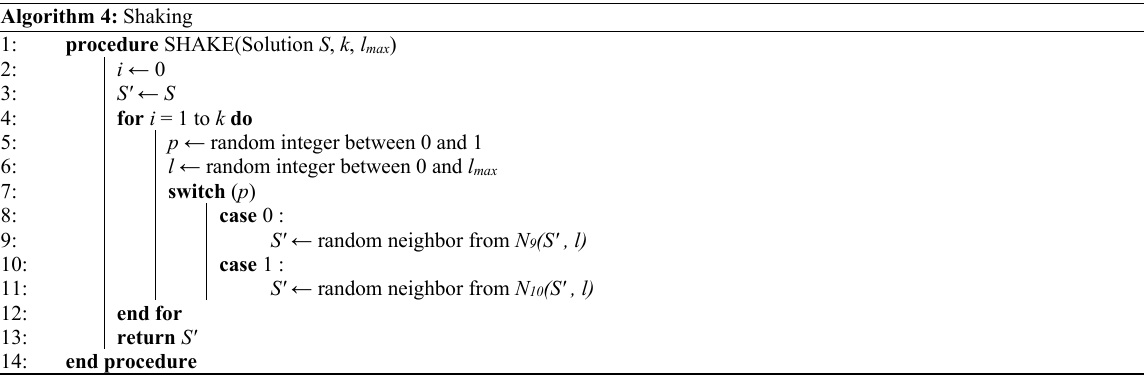
Algorithm 4. In the main loop of the algorithm (Lines 4-12), we first randomly select a neighborhood structure (Line 5) and the size of that neighborhood (Line 6). The size is limited by the parameter 𝑙 the selected neighborhood structure and size (Lines 9 and